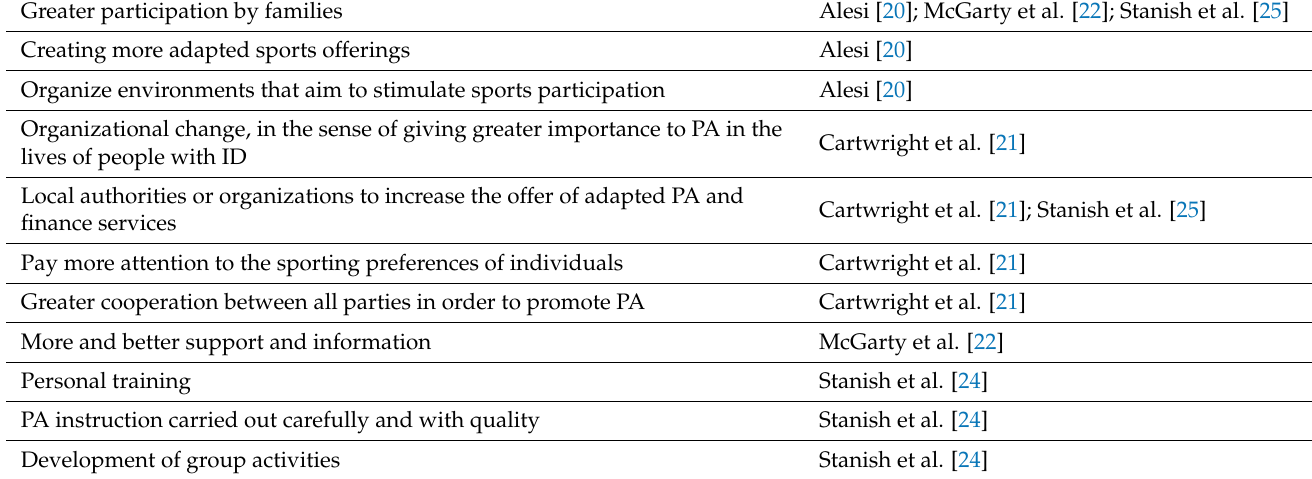
Table 7. Summary of study